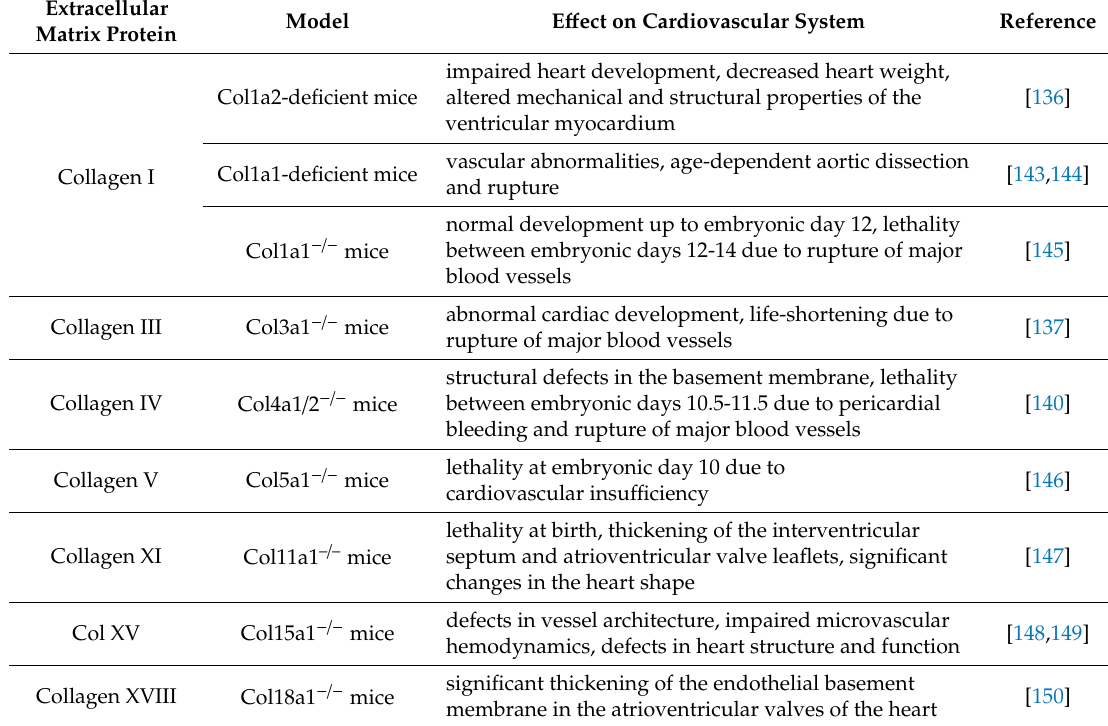
Table 1. Mouse models with altered gene expression demonstrating the role of individual extracellular matrix proteins in heart